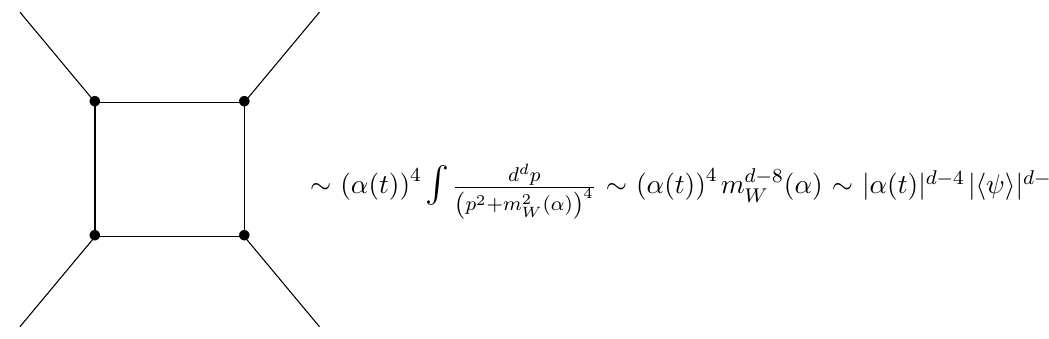
Figure 3 . One-loop box diagram in d spacetime dimensions. The external lines are associated with the Cartan generator t and the W-Bosons running in the loop correspond to a root (cid:11)